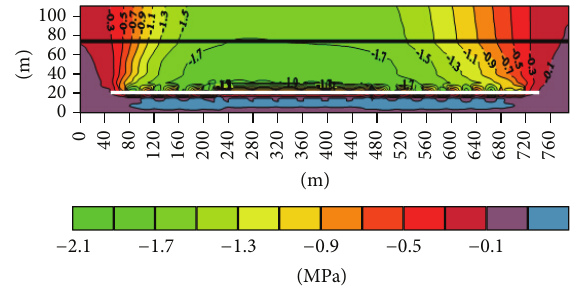
Figure 5: The surrounding rock vertical shift profile along the working face advancing